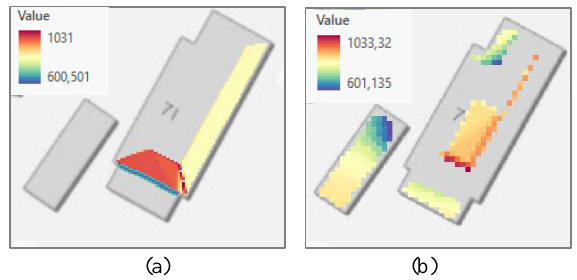
Figure 11. The result of the physical potential calculation with the converted 3D building model at the first row and the DSM at the second row. Pixel size 0.2m and 0.5m for picture (a), (c) and (b), (d) respectively.